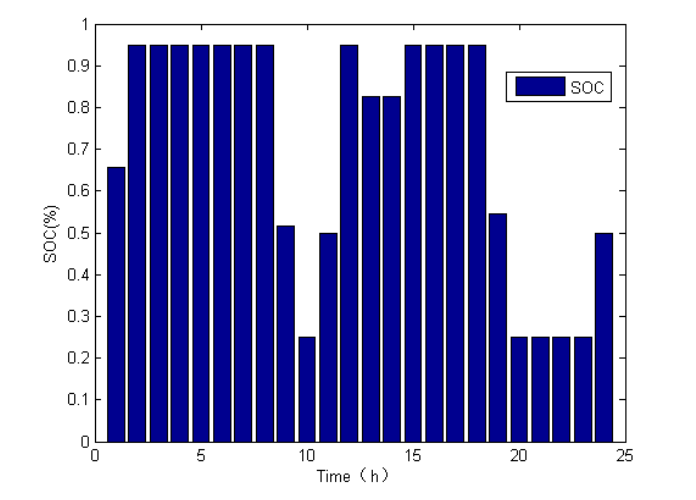
Figure 8. The SOC of ESS.